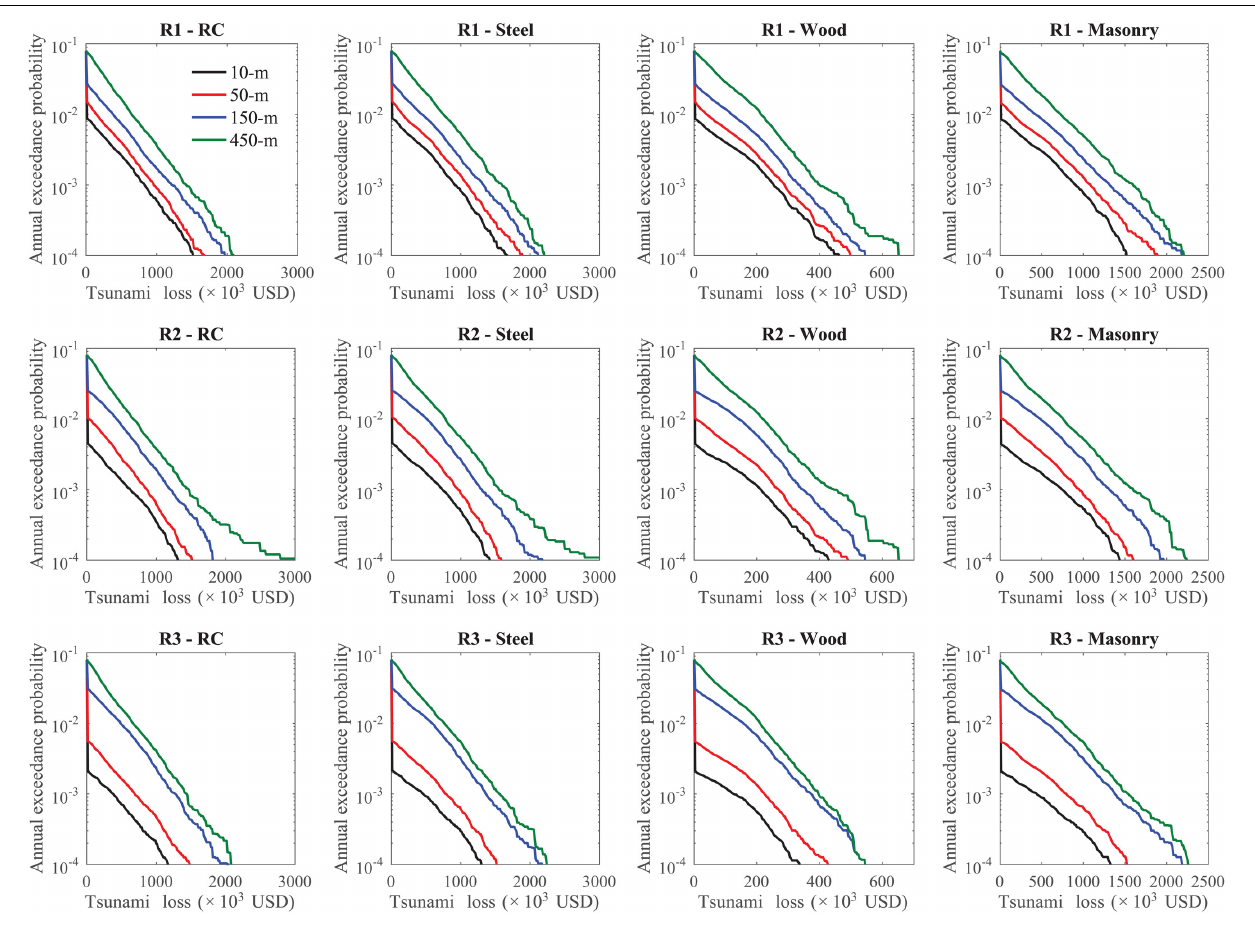
FIGURE 13 | Tsunami loss curves at three locations in